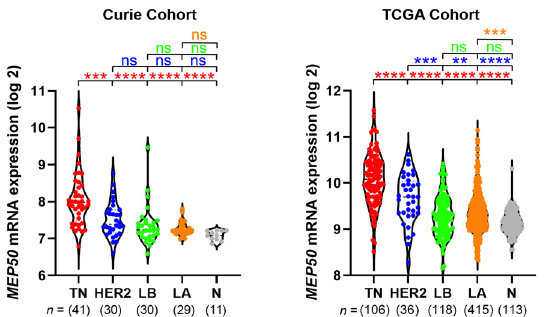
Figure 1. TNBC express high levels of MEP50 mRNA. MEP50 mRNA expression in the different breast cancer subgroups and in normal breast tissues in Curie ( left panel ) and TCGA ( right panel ) cohorts. The breast cancer subgroups are ordered left to right from the most to the least proliferative tumors: TNBC (TN, red), HER2 (blue), luminal B (LB, green), luminal A (LA, orange). Normal breast tissues (N) are in grey. Relative RNA quantifications are logarithmically (log2) transformed and illustrated by violin plots with each sample represented by a circle. The statistics in red indicate the comparison vs. TN, in blue vs. HER2, in green vs. LB, and in orange vs. LA: ns (not significant), ** p < 0.01, *** p < 0.001, **** p < 0.0001.